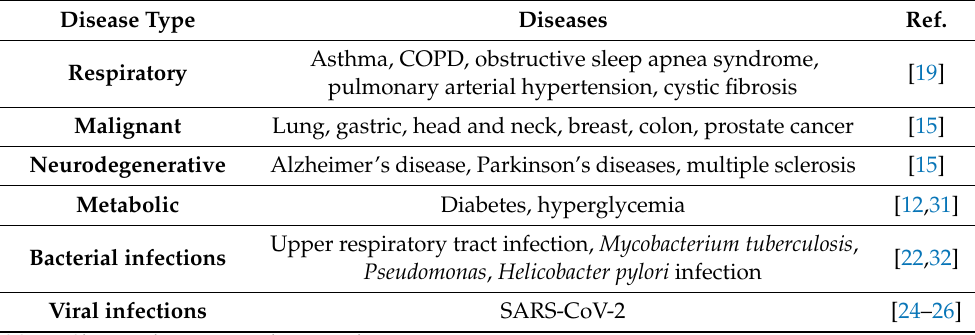
Figure 1. Diagram summarizing the correlation of VOCs present in the exhaled breath, with oxidative stress and inflammatory conditions; metabolic breakdown of larger molecules leads to the formation of exhaled VOCs. Reprinted with permission from ref. [17]. Copyright © 2012 John Wiley & Sons Ltd. Table 1. Diseases investigated for diagnosis using breath